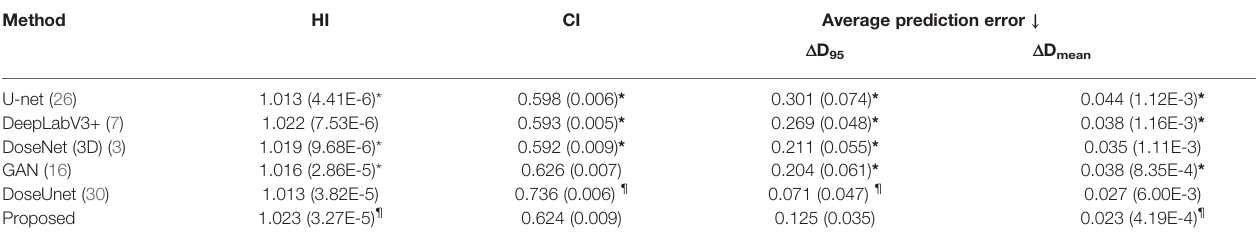
TABLE 2 | Quantitative comparisons with four mainstream dose prediction methods in terms of HI, CI, D95, and Dmean. Method